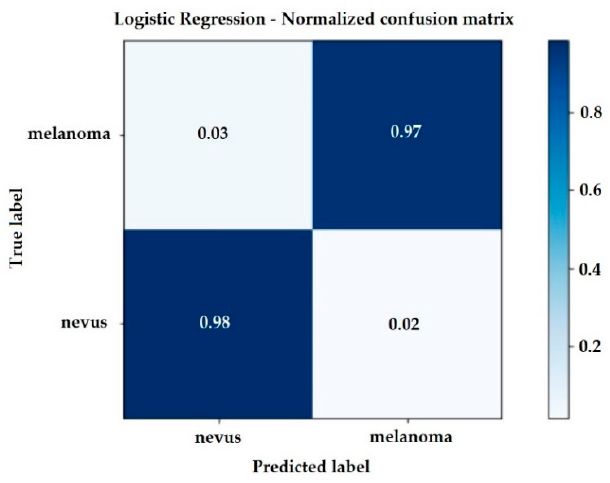
Figure 6. Confusion Matrix considering the Logistic Regression Model.